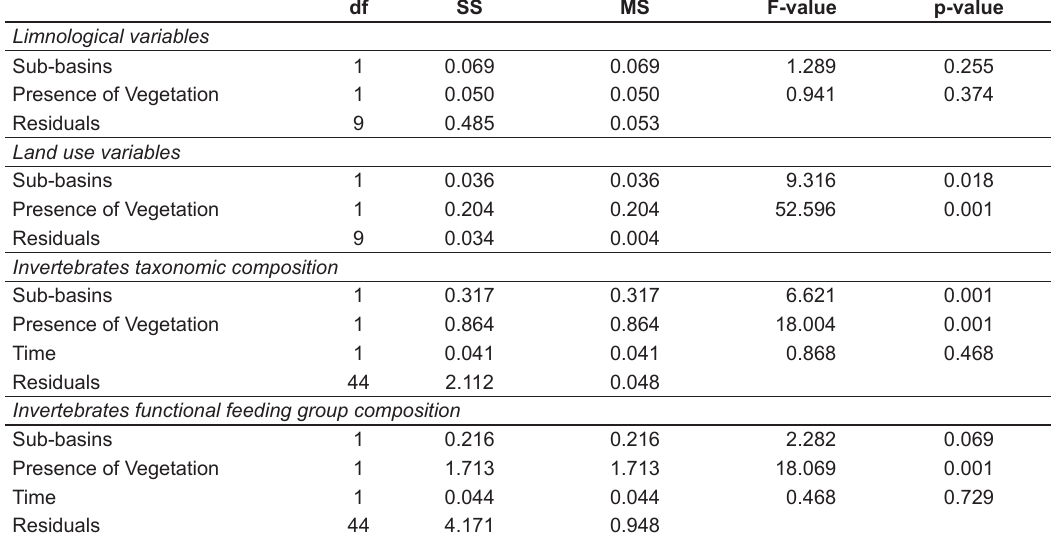
Table 2. PerMANOVA results of the environmental variables (limnological and land uses) and taxonomic and functional composition invertebrate fauna in the Campo river hydrographic basin and Cravo river hydrographic basin, Southern Brazil.